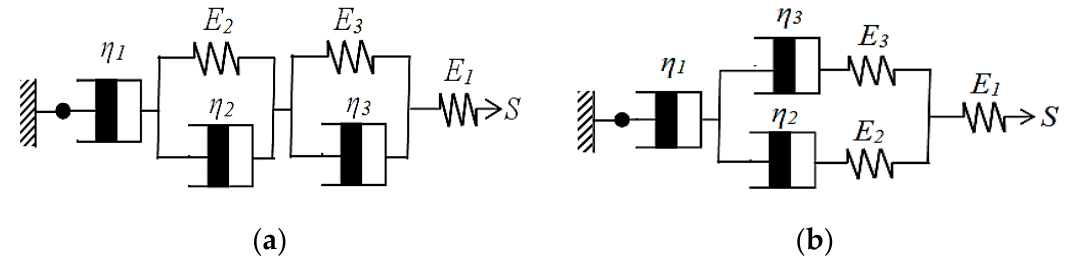
Figure 3. Creep prediction models ( a ) Model A ( b ) Model B.